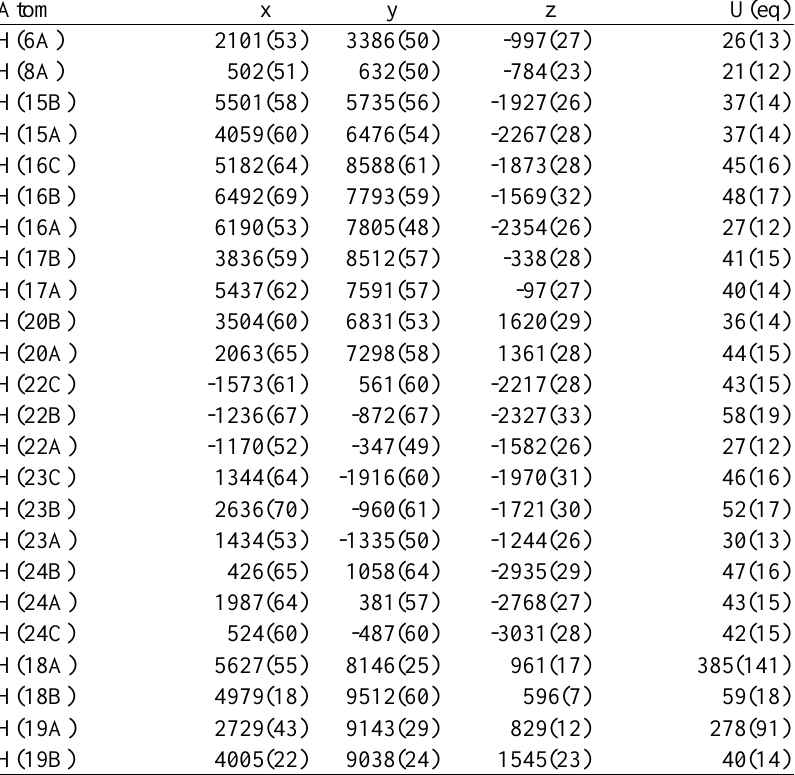
Hydrogen coordinates (x 10 4 ) and isotropic displacement parameters (Å 2 x 10 3 )